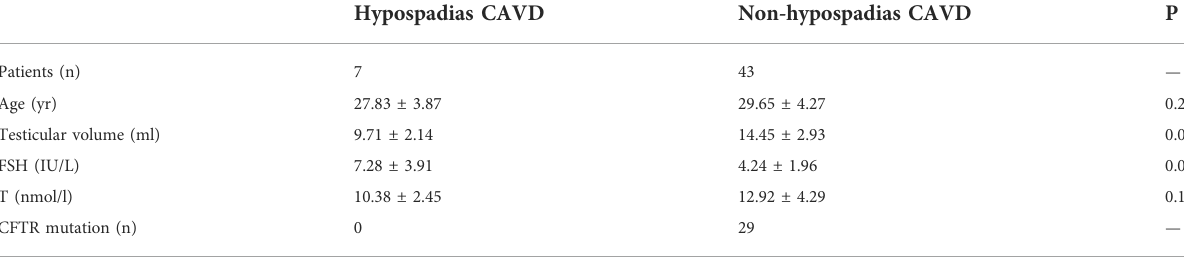
TABLE 1 Comparison between hypospadias CAVD and non-hypospadias